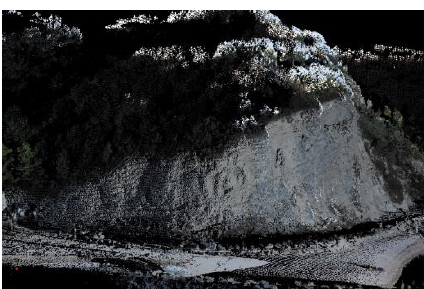
Figure 4. TLS RGB cloud elevation points